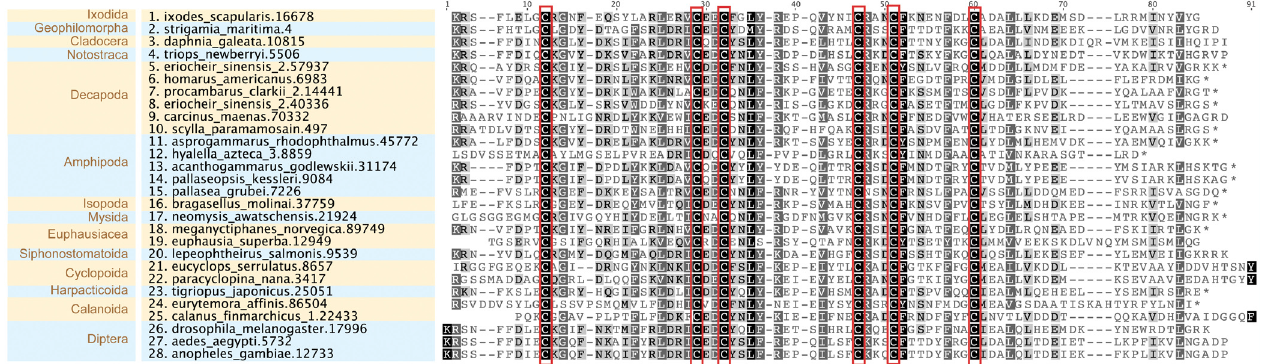
Figure 3. Multiple sequence alignment of representative CHH/MIH/GIH proteins from each taxon. Six conserved cysteine residues are annotated within red